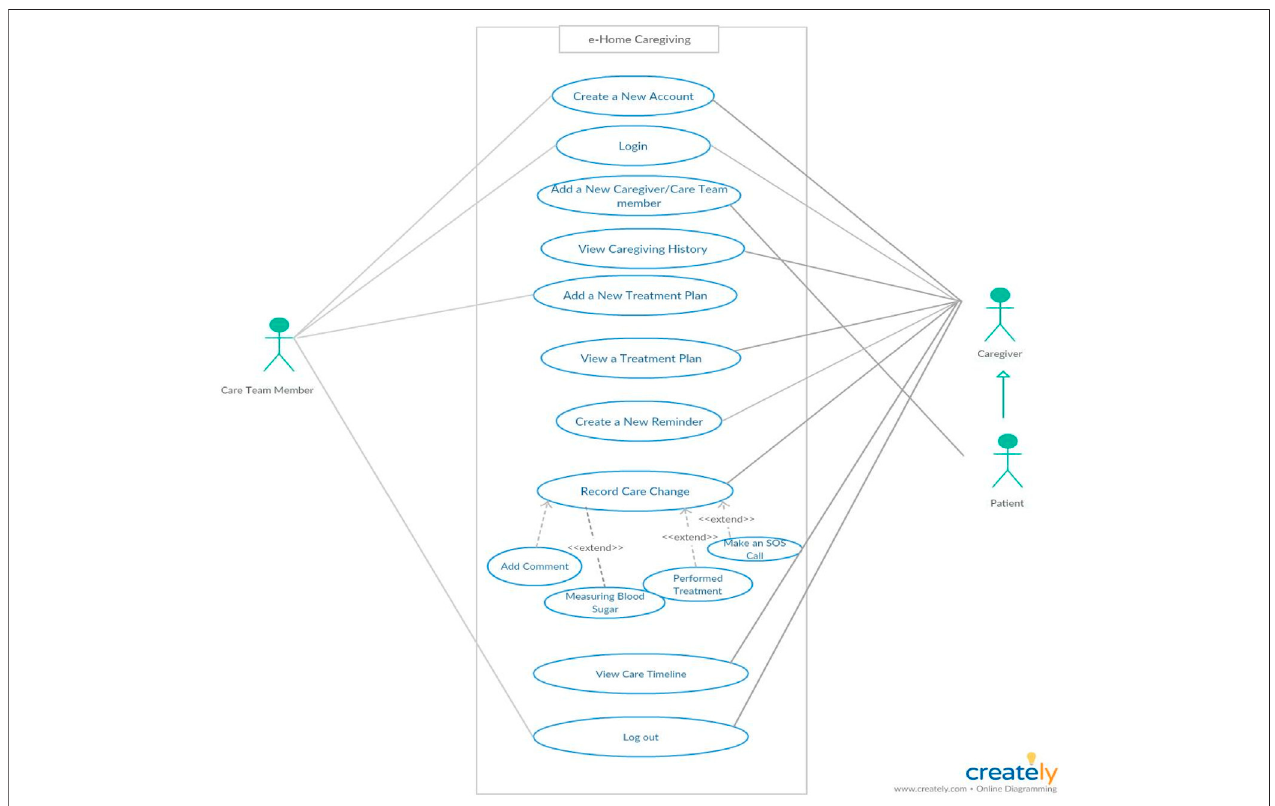
FIGURE 6 | eHomeCaregiving use